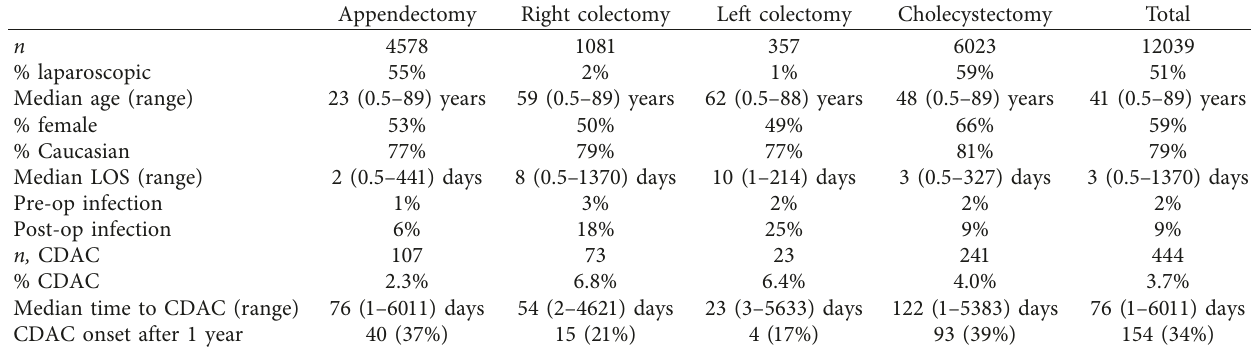
Table 1: Demographic and clinical data according to the four